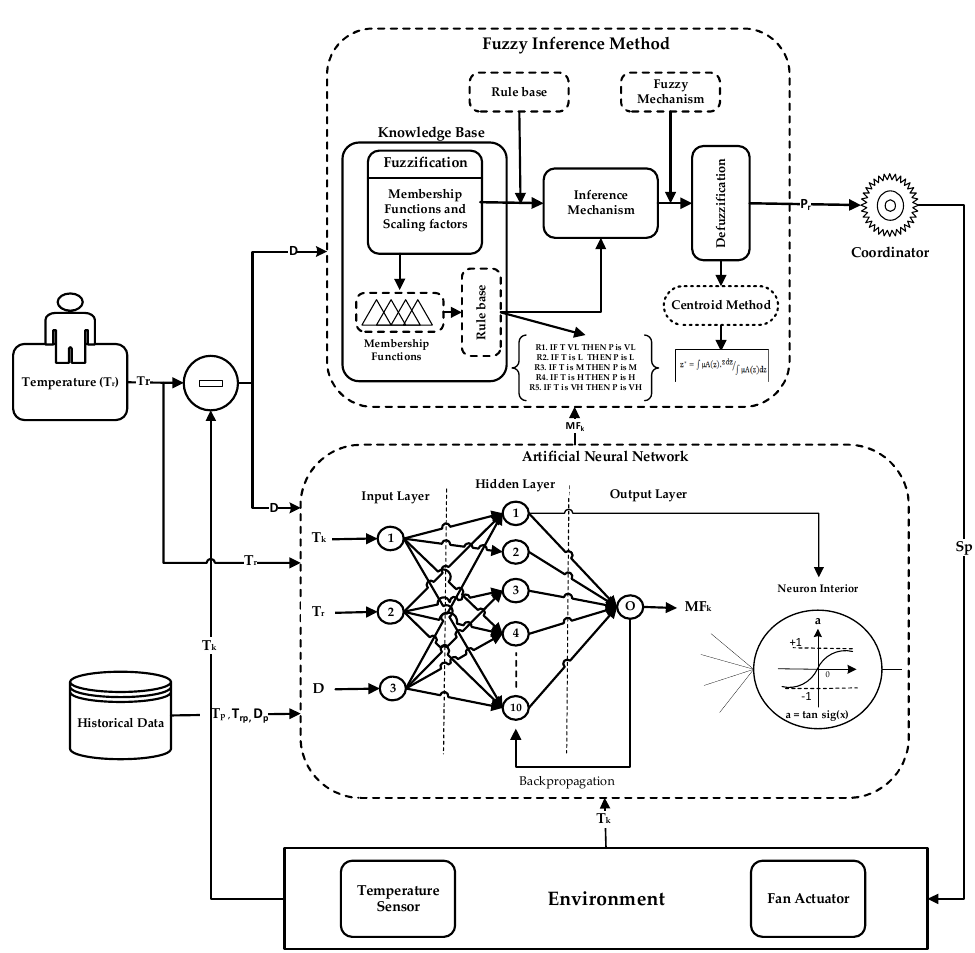
Figure 3. Detailed processing diagram of the learning-to-control model.